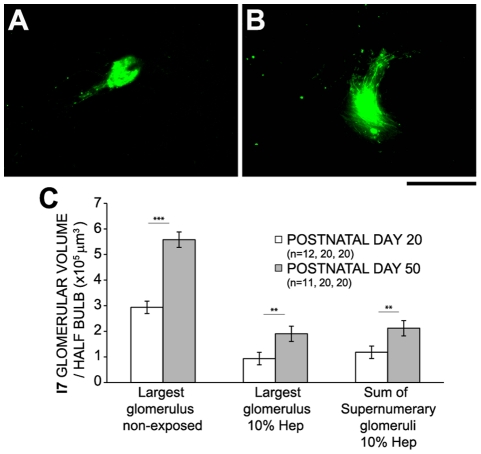
Supernumerary glomeruli grew in size after interrupting chronic odorant exposure.Figures A and B show representative I7tauGFP supernumerary glomeruli at postnatal day (PD) 20 and at PD50, respectively, from 10% heptaldehyde exposed mice. Scale bar 100 µm. Bar graph in C depicts the average I7 glomerular volume per half bulb, at PD20 and PD50, of the largest glomerulus in non-exposed mice, and the largest glomerulus and the sum of supernumerary glomeruli in mice exposed to 10% heptaldehyde (10% Hep). Non paired t-test: **, P<0.01; ***, P<0.001.